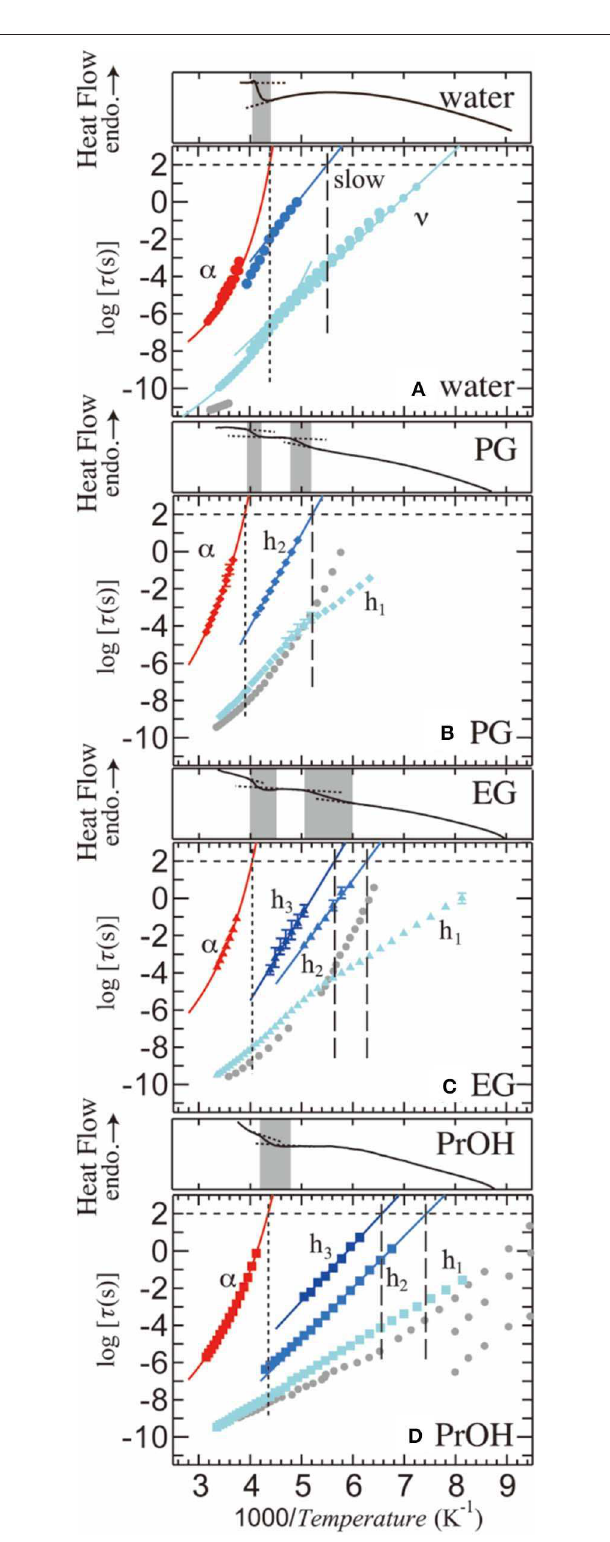
FIGURE 5 | Relaxation time as a function of inverse temperature for the 65 wt% (A) PVP–water, (B) PVP–PG, (C) PVP–EG, and (D) PVP–PrOH mixtures.